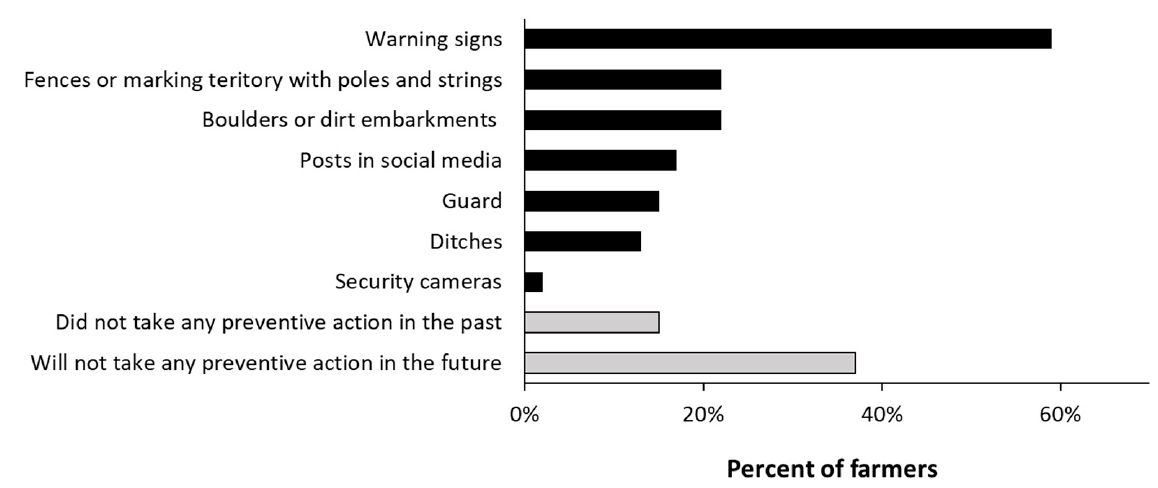
Figure 2. Actions farmers have taken in the past five years (blue bars) to reduce ROV damage in their fields.